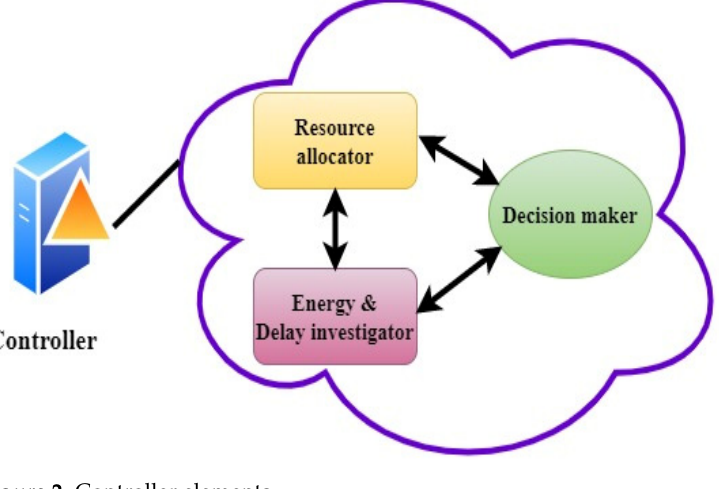
Figure 2. Controller elements.